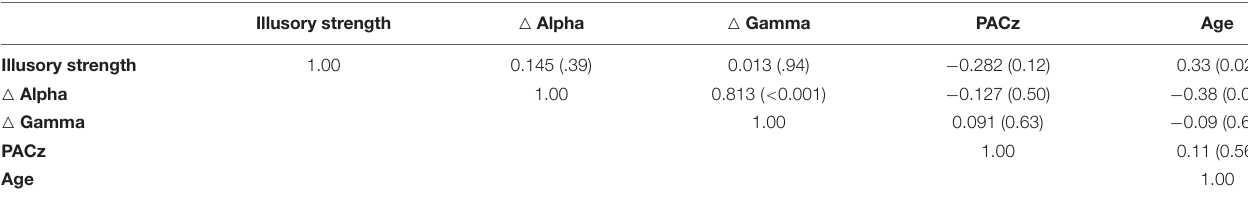
FIGURE 8 | Phase-locked power spectrum of the gamma band. Normalized time-frequency maps are displayed for non-illusion (top row) and illusion (bottom row) conditions within each group (YA: left column; NF: middle column; FH: right column). Power estimates in the low gamma range were extracted within a 200 ms time window time-locked to the peak of 10. 5 Hz alpha activity (middle row) and averaged over epochs. This methodology revealed bursts of gamma activity coupled to the troughs of alpha activity during no-illusion conditions in YA and NF group. Power values are displayed in dB. TABLE 3 | Pearson r and associated uncorrected p values (in parentheses) from correlations between illusory strength and EEG measures ( (cid:52) Alpha, (cid:52) Gamma, PACz) and age. Illusory strength (cid:52) Alpha (cid:52)